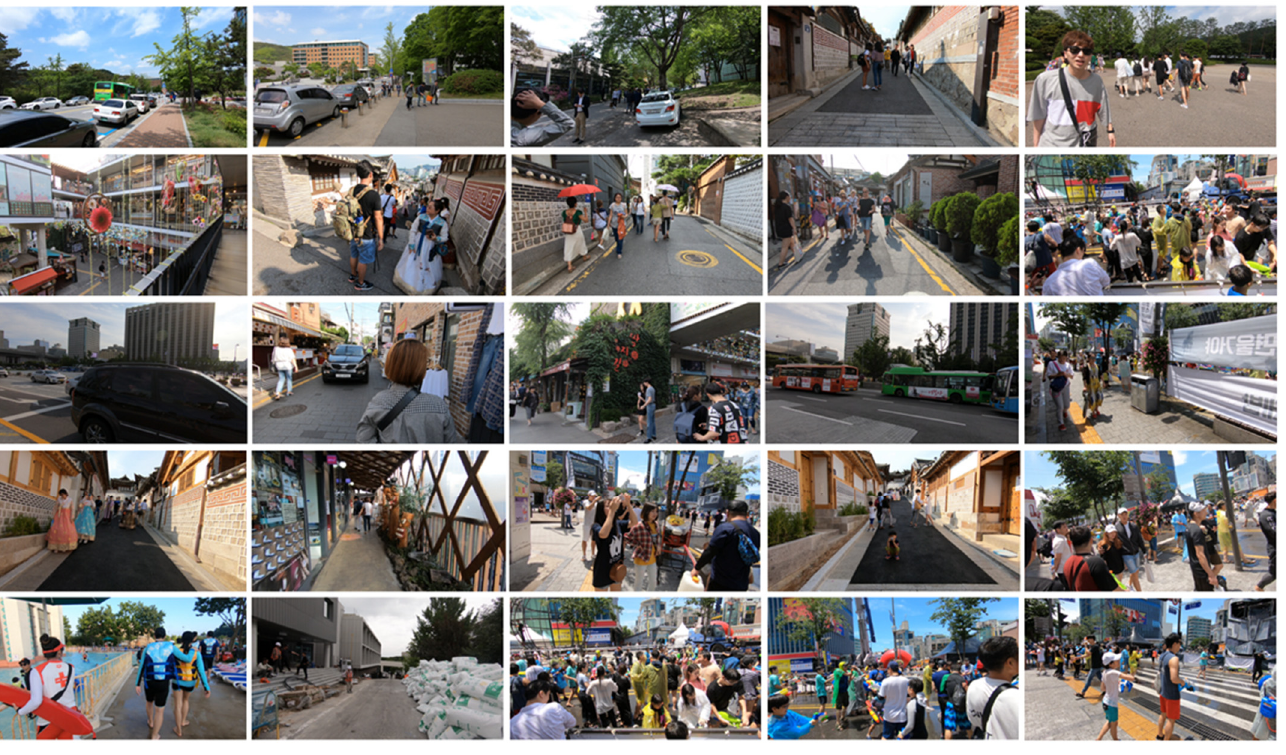
Figure 12. REDS training and test dataset.